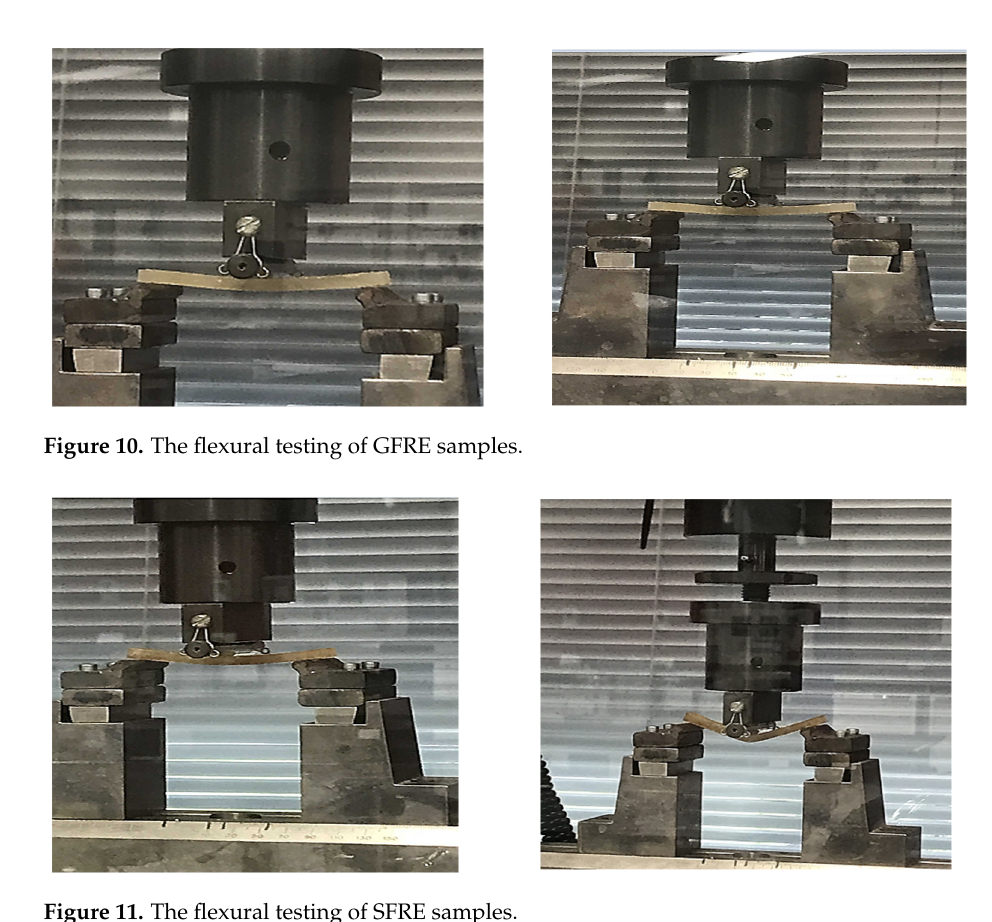
Table 5. Property materials utilized in ANSYS